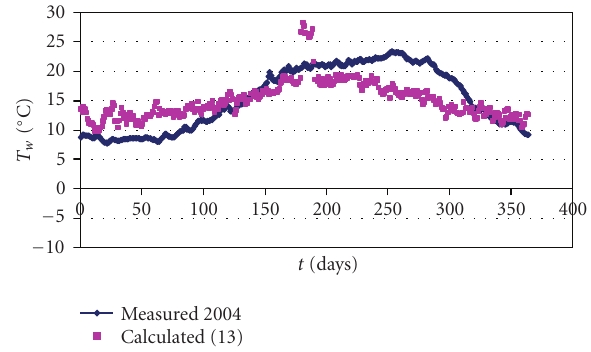
Figure 15: Comparison between measured and estimated data (16), correlation coe ffi cient r Tw , Tw 1 = 0 . 9612.